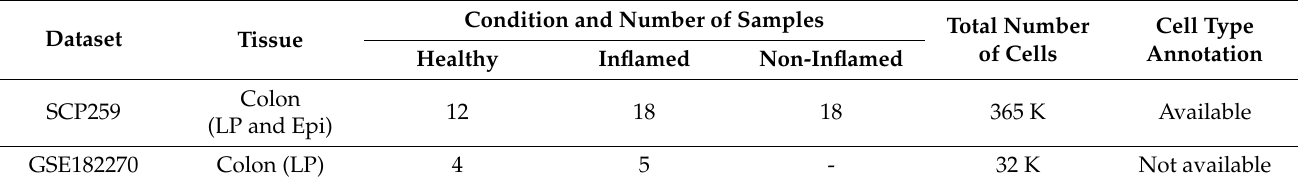
Table 1. Datasets used for the